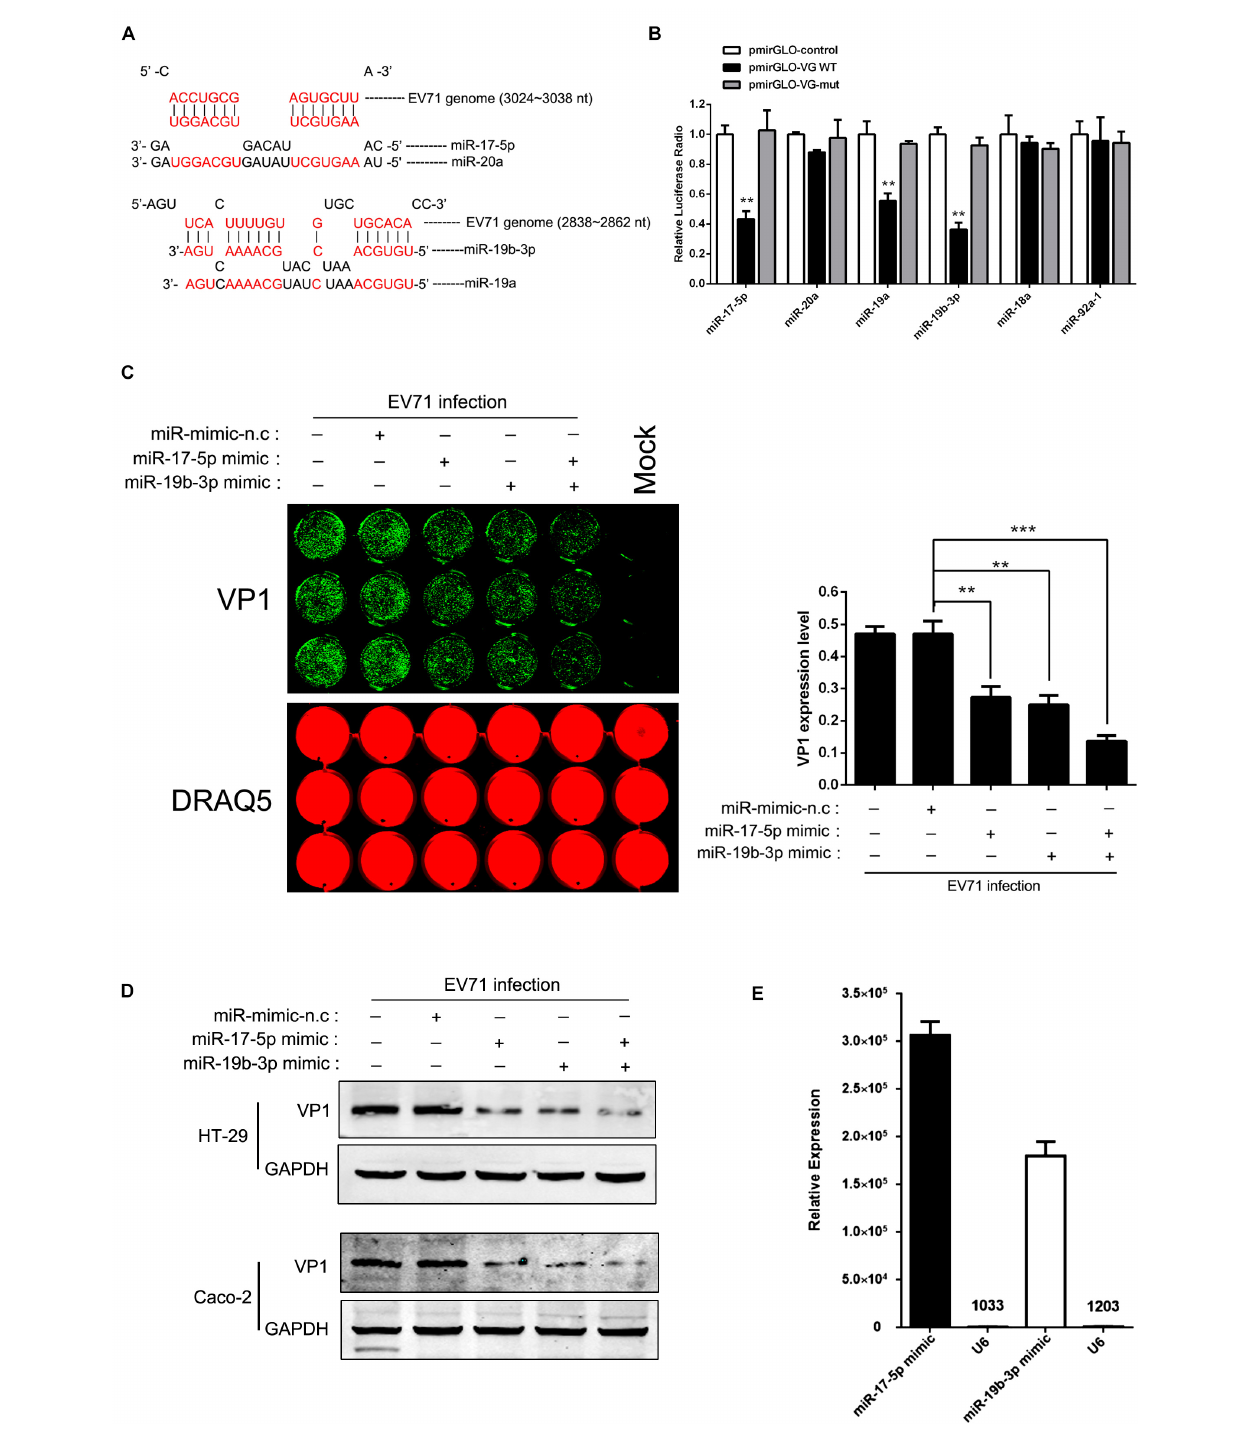
FIGURE 3 | miR-17-5p, miR-19a, and miR-19b directly targeted the EV71 genome. (A) Potential target sites of mature miRNAs of the miR-17-92 cluster in the EV71 genome. Computational analysis with RNA-hybrid software yielded potential binding sites for miR-17, miR-20a, and miR-19a/b in the EV71 genome. (B) EV71 genome containing presumptive miR-17-92 target sequences, was cloned into the multiple cloning sites at the 3 (cid:48) of the firefly luciferase reporter gene (luc2) in the luciferase expression plasmid (pmirGLO). Either control plasmid (pmirGLO-control), pmirGLO-viral genome WT (pmirGLO-VG WT) or pmirGLO-viral genome mut (pmirGLO-VG-m) was co-transfected with individual miRNA mimic in HT-29 cells. The luciferase activity of pmirGLO-VG WT group was repressed by transfecting miR-17 and miR-19a/b while mutation of a predicted miRNAs binding sites abolished miRNAs-mediated repression. (C,D) HT-29 cells and Caco-2 were infected